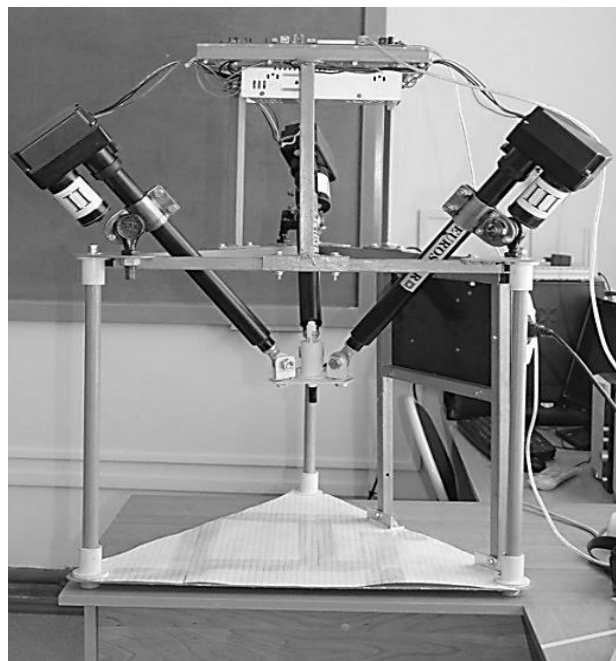
Figure 8. Robot "Tripod Manipulator"